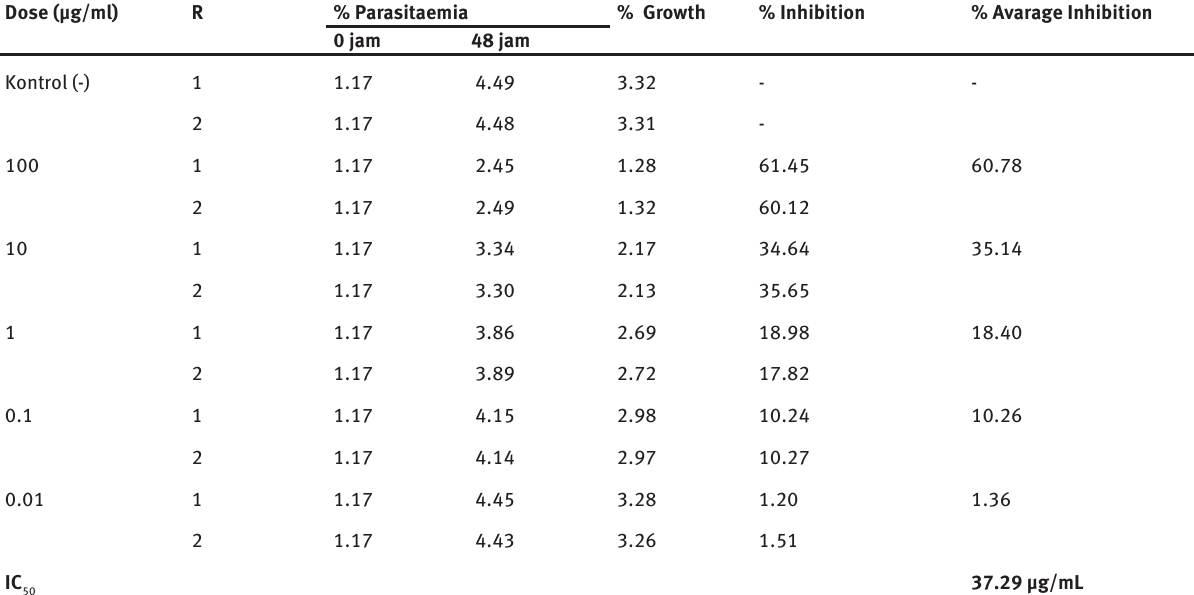
Tabel 2: Antimalarial activity of 6-hydroxyistigmast-4-en-3-one against P. falciparum